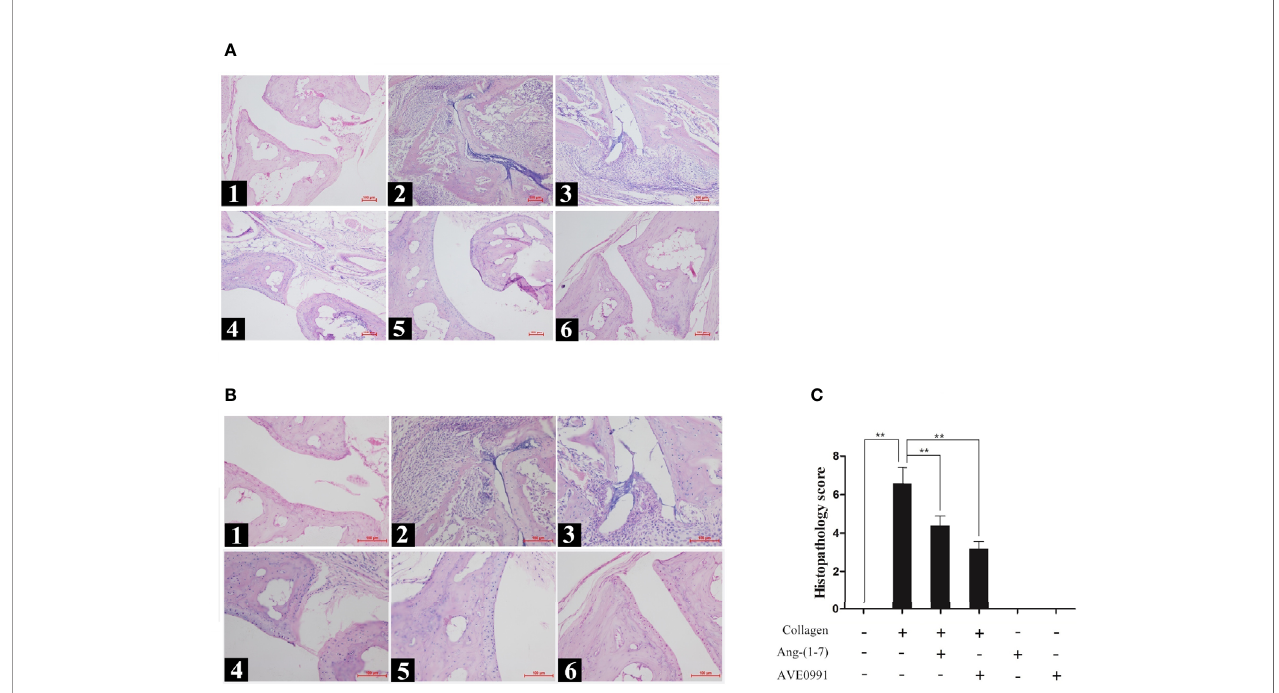
FIGURE 2 | H&E staining of ankle in mice. (A1, B1) Control group, (A2, B2) CIA group, (A3, B3) CIA + Ang-(1 – 7) group, (A4, B4) CIA + AVE0991 group, (A5, B5) Ang-(1 – 7) group, (A6, B6) AVE0991 group. Magni fi cation =100× (A) and 200× (B) . (C) The ankle pathological score was graded in a blinded manner. Values are expressed as means ± SD (n = 6), **P<0.01.